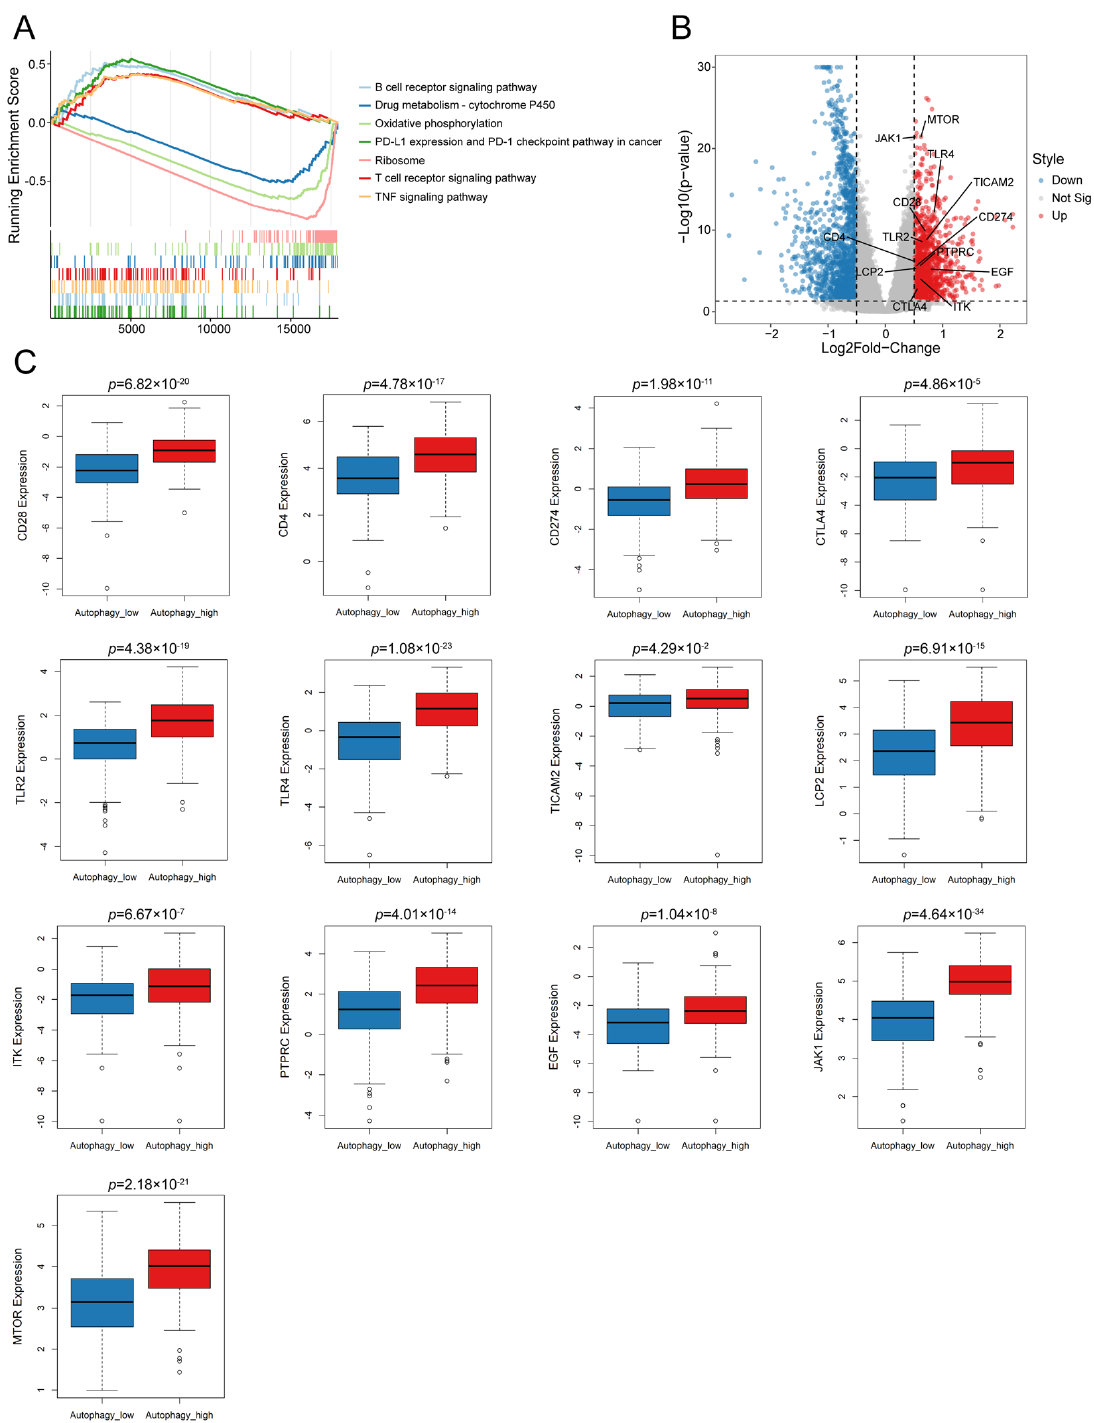
Figure 2. The relationship between autophagy and immune-related signaling in OC: ( A ) GSEA enrichment analysis showed immune-related signals were positively enriched in the autophagy high group. Volcano plot ( B ) and box plot ( C ) showed the expression levels of immune-related genes (CD28, CD4, CD274, CTLA4, TLR2, TLR4, TICAM2, LCP2, ITK, PTPRC, EGF, JAK1 and mTOR) in autophagy high and low group (Two-tailed student’s t test, p < 0.05 was considered to be signifi- cant).